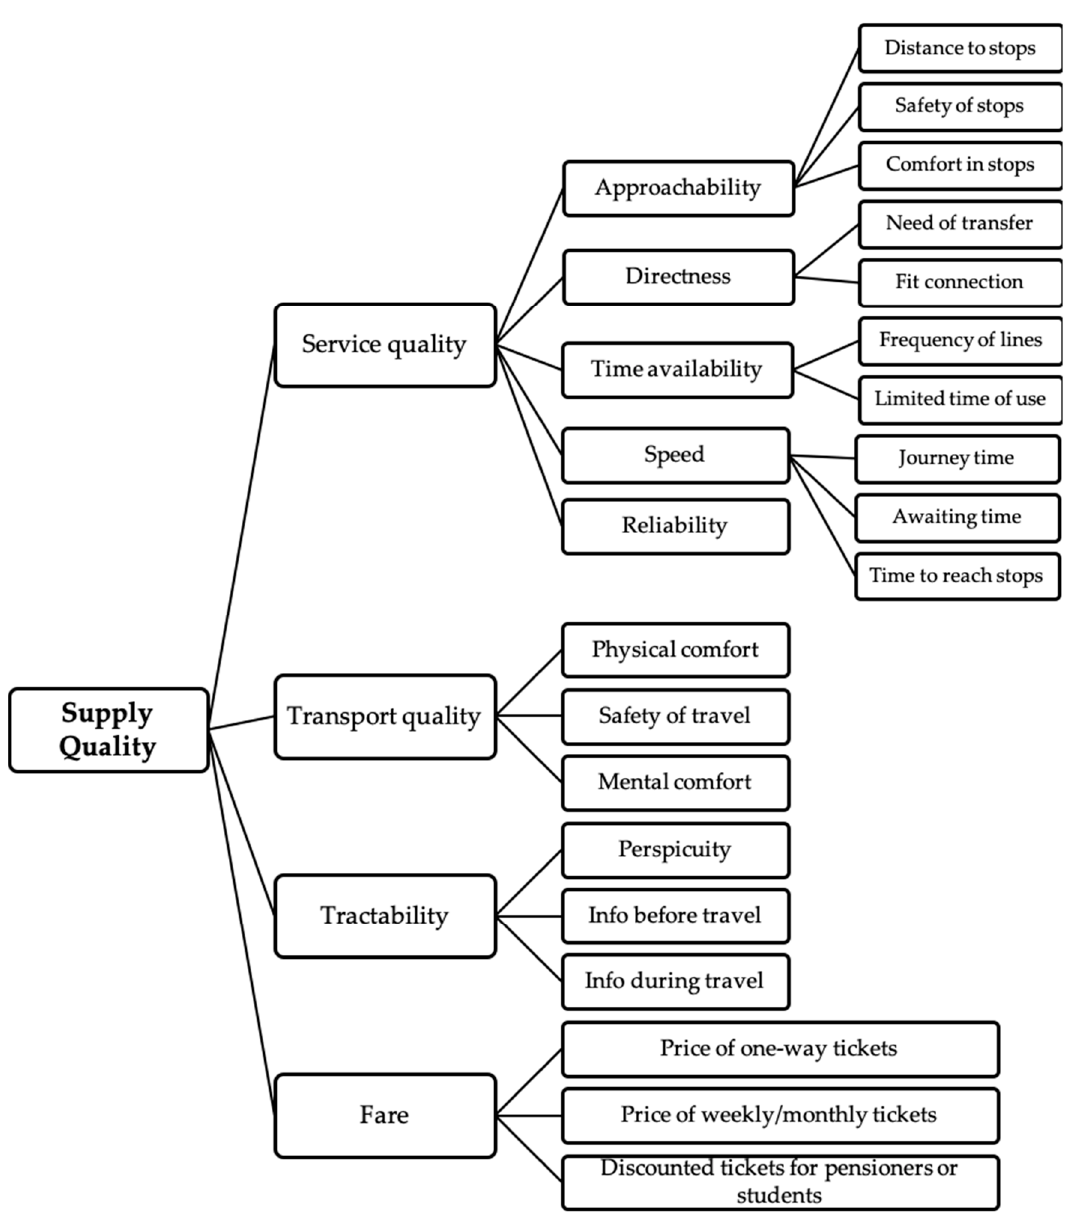
Figure 2. The Hierarchal Model for the integrated survey on public transport demand (Source: own).